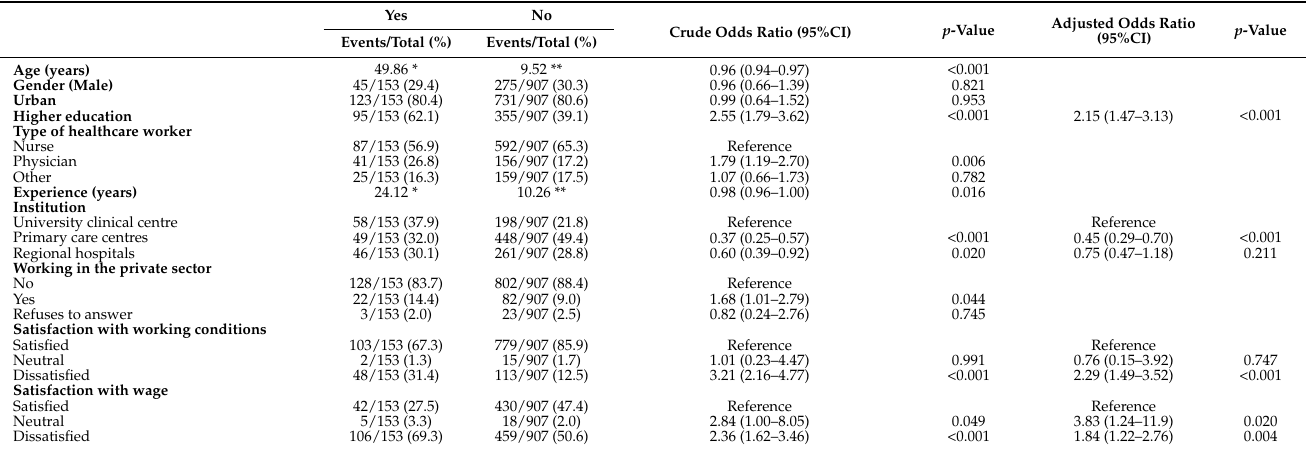
Table 3. Preference for migration.